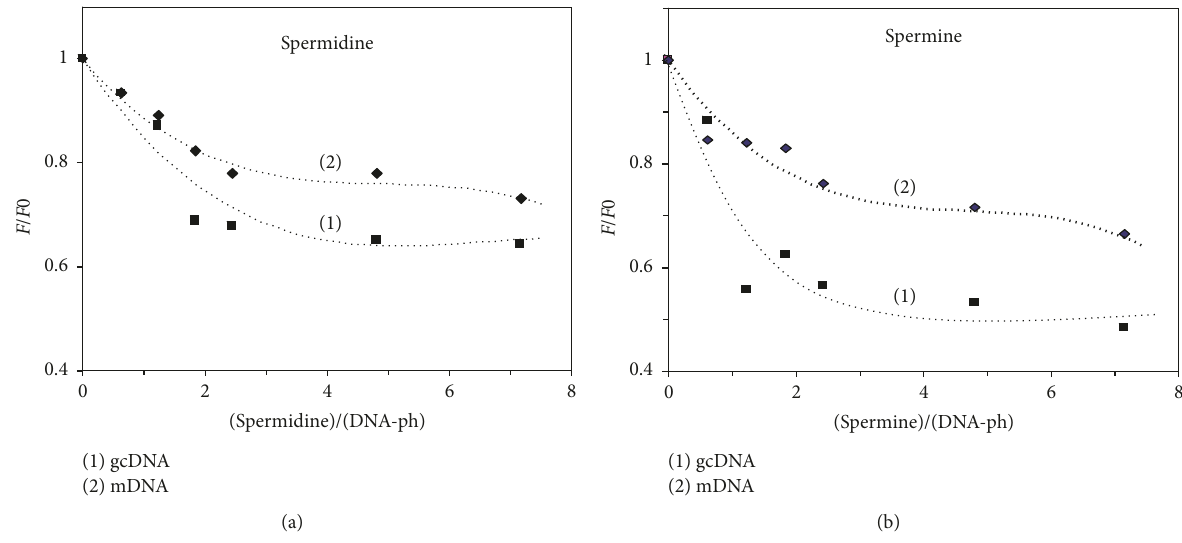
Figure 7: The effect of increasing concentrations of spermine and spermidine on the quenching of YOYO fluorescence bound to gcDNA and mDNA. 𝐹 0 and 𝐹 are the fluorescence intensities of the dye in the presence of DNA before and after the addition of amines, respectively. (a) Spermidine. (b) Spermine. (1) and (2) are the results in gcDNA and mDNA in Hepes buffer, pH 7.4 containing 100mM NaCl. Dye to DNA-phosphate ratio 1:50. Fluorescence setup: excitation, 485 nm; emission 505 nm. Temperature 20 ∘ C.